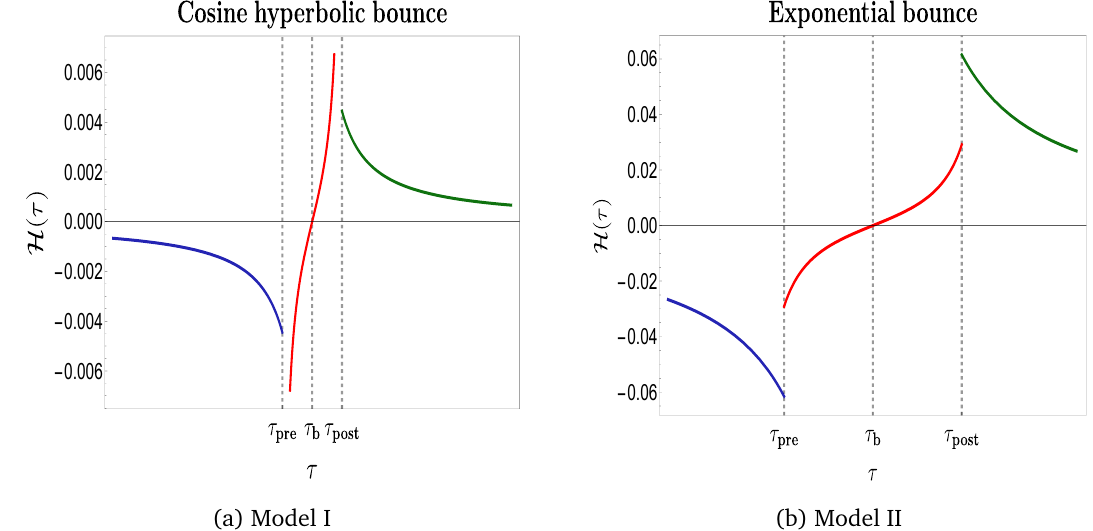
Figure 5: Variation of Hubble paramter wrt the conformal time showing three differ- ent regions viz. Pre-bounce, Bouncing and the Post-bounce